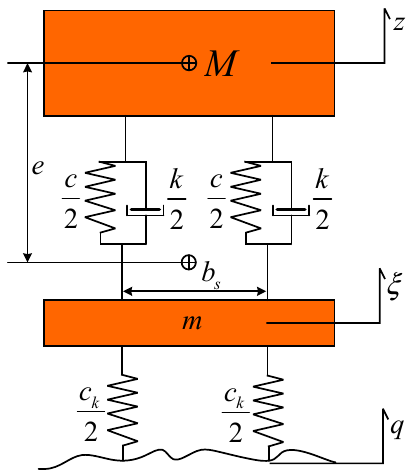
* 10 2 is the variance of normal probability distribution.